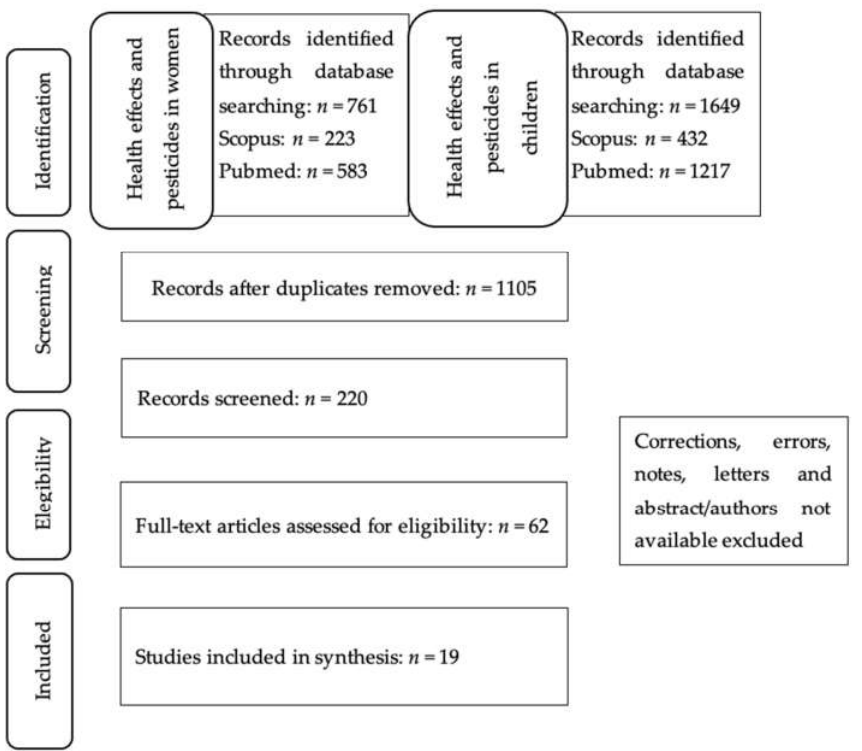
Figure 1. Schematic representation of data handling .